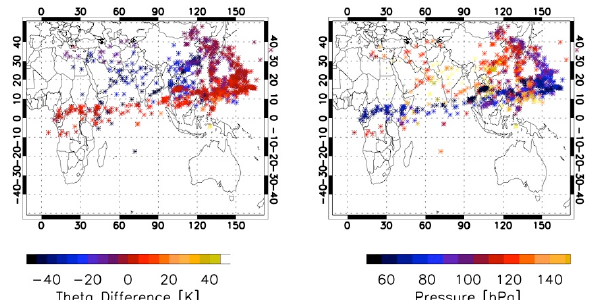
Fig. 7. Origins of M55 flight track back trajectories from below 800hPa, colour coded in terms of ozone in ppbv (left panel) and water vapour in ppmv (right panel) observed along the flights.